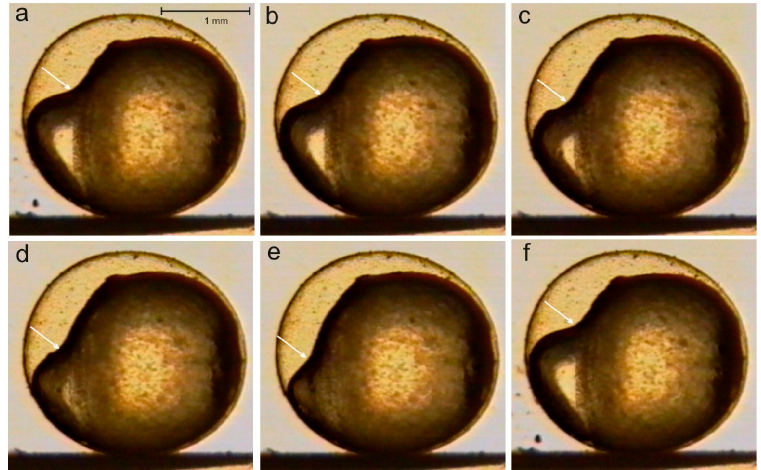
Figure 1. A quasi-peristaltic wave moving over the egg surface in the northern pike in a 4 mT static magnetic field (SMF); lateral view, ¾ epiboly; changes recorded at 1 min intervals indicated with an arrow ( a – f ); the moving wave causes changes in the embryo’s position inside the egg envelope [43].